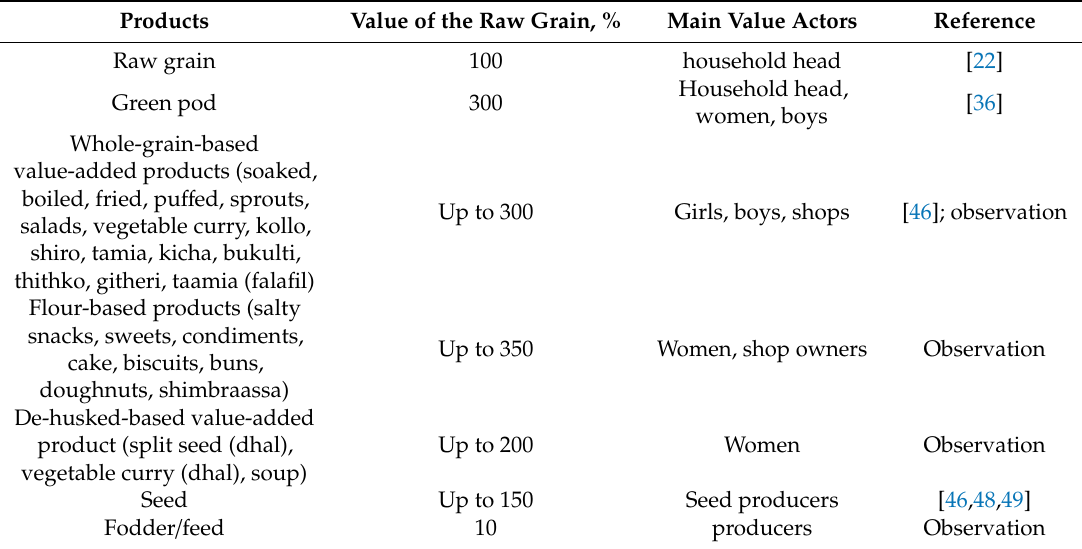
Table 2. Chickpea value junctions and the main actors in the primary chickpea growing countries in SSA.